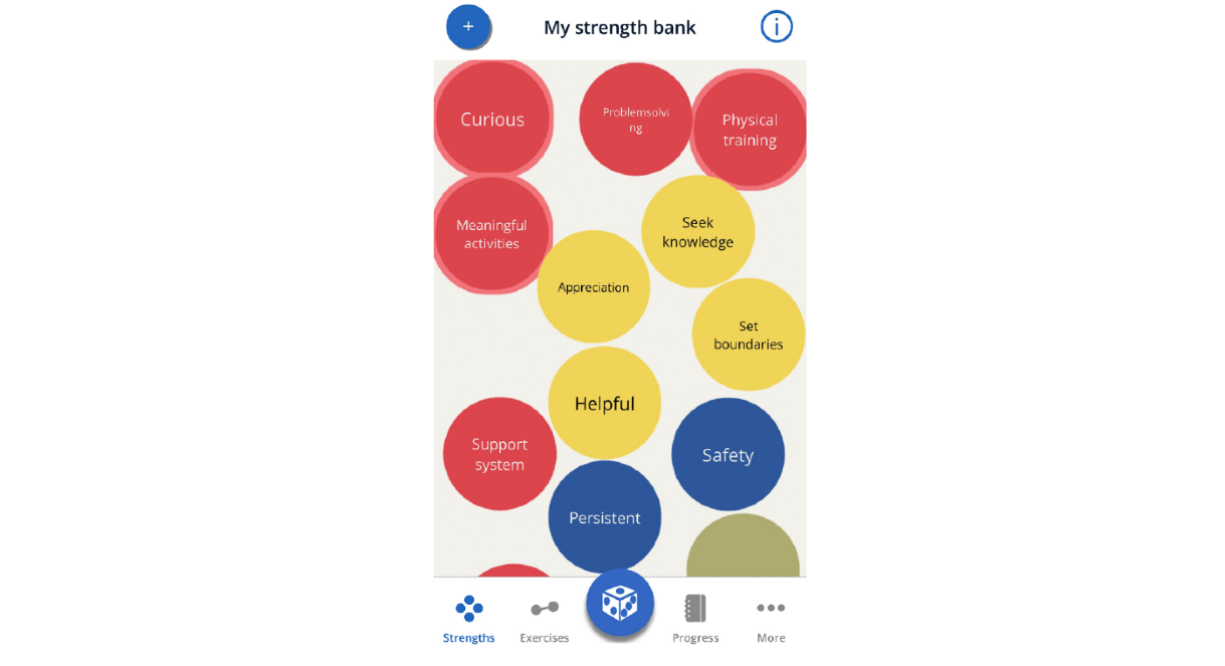
Figure 11. MyStrengths Home